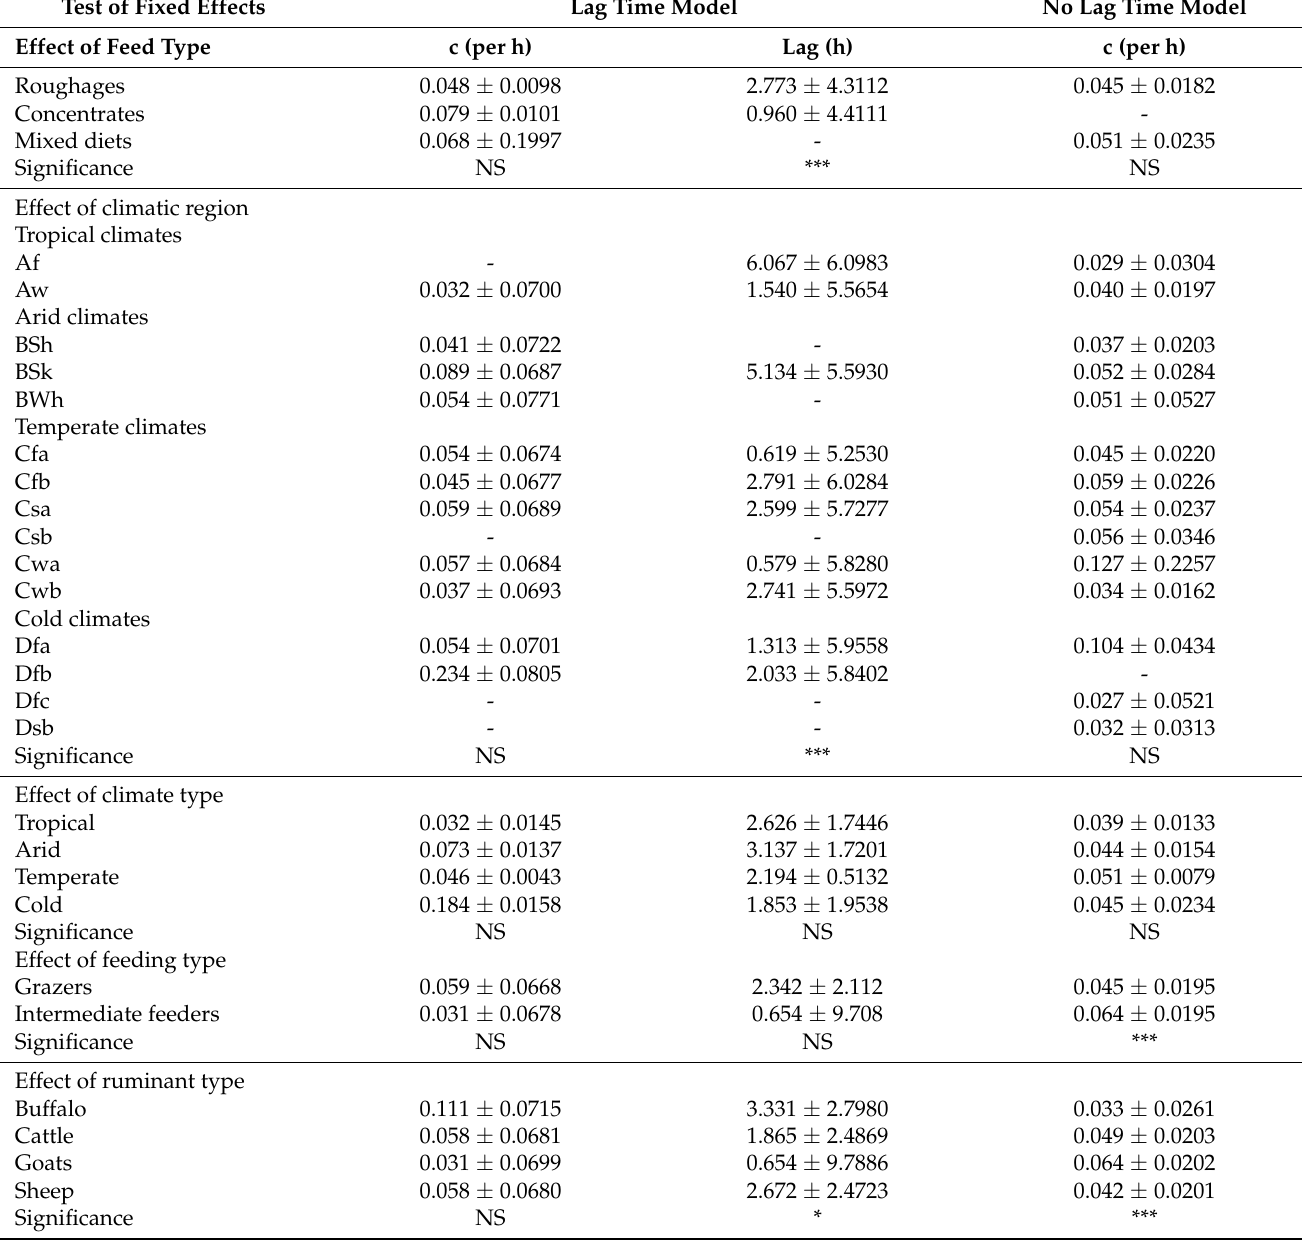
Table 7. Effects of feed sample and diet properties, ambient temperature, ruminant type and feeding type, and climatic region on rumen degradation of